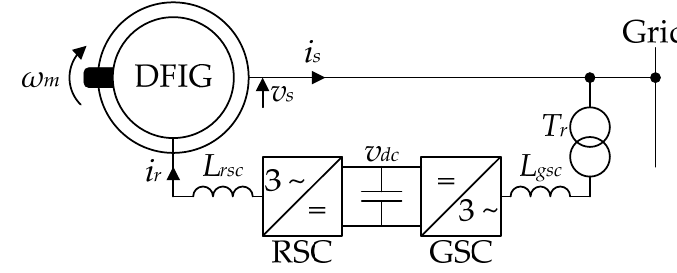
Figure 1. Doubly ‐ fed induction generator (DFIG) ‐ based, variable speed, grid ‐ connected generation system. Figure 1. Doubly-fed induction generator (DFIG)-based, variable speed, grid-connected generation